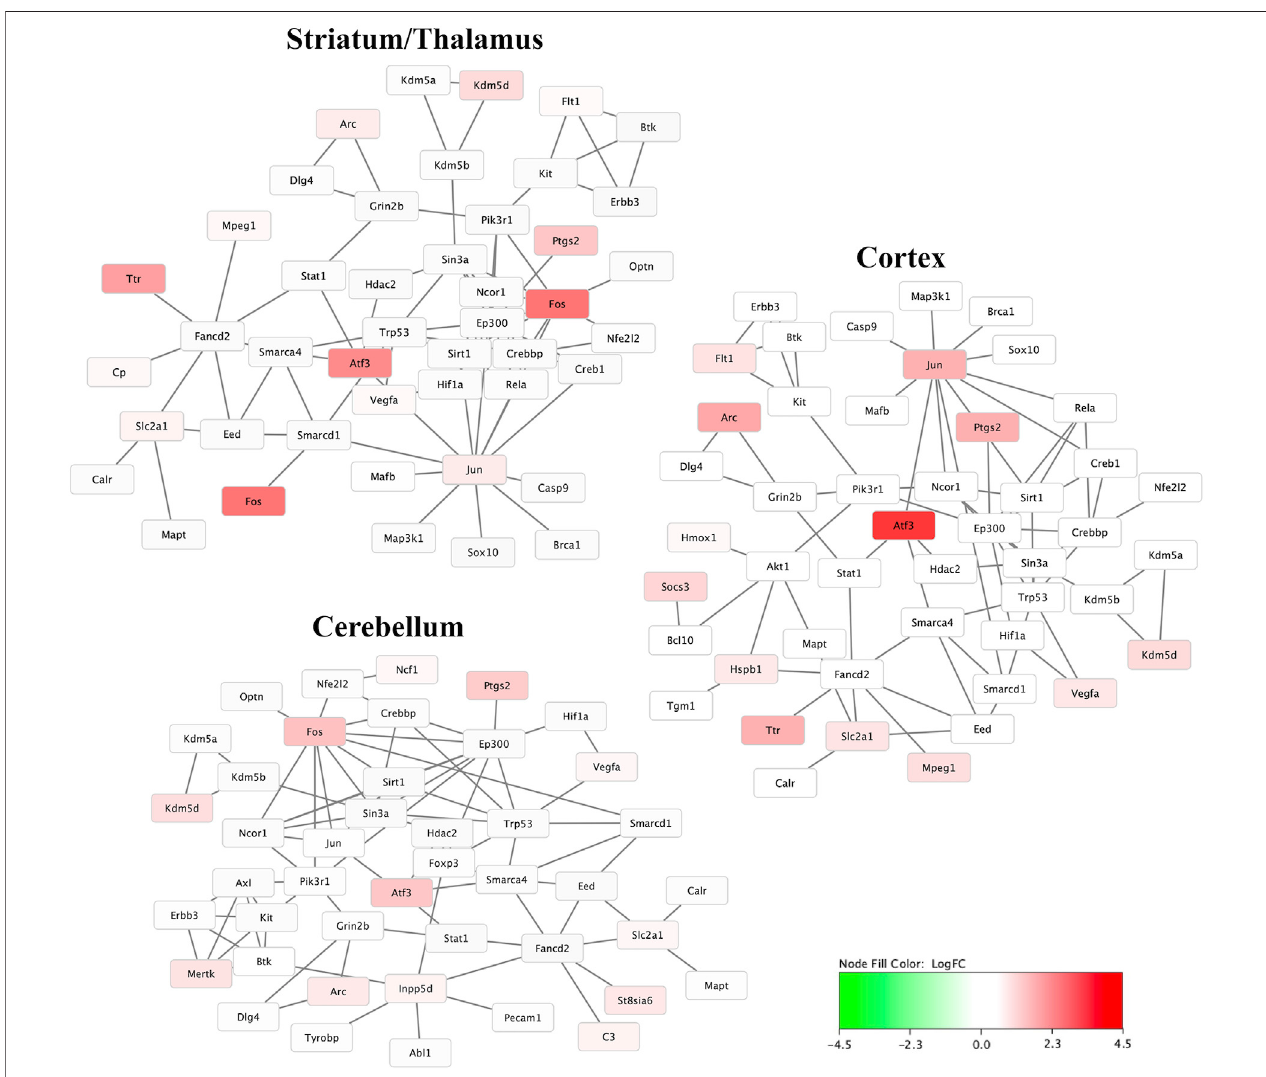
FIGURE 4 | Messenger RNA (mRNA) networks in each region representing the mRNA with signi fi cant differential expression after hypoxic-ischemic brain injury versus controls and two degrees of connection between those mRNA and the other mRNA analyzed in this study. Not shown are any mRNAs with no, or only one, connection. Node fi ll color relates to the log fold change of mRNA in hypoxic-ischemic brain injury compared to controls.